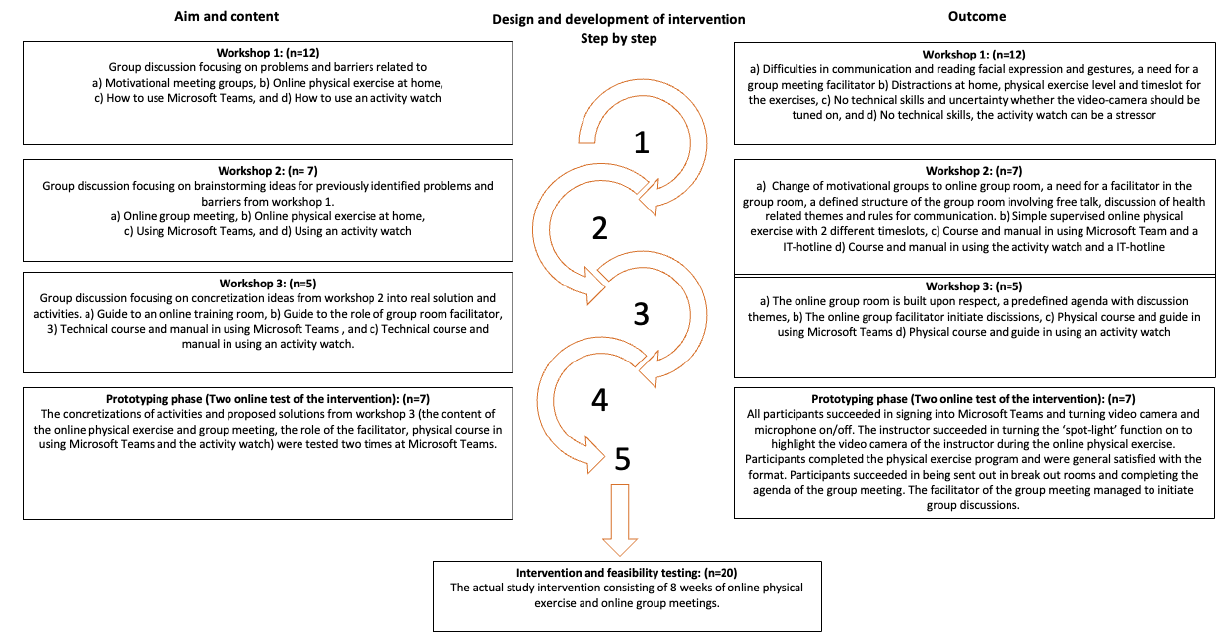
Figure 1. Design and development of the intervention using a co-creation approach. The development consisted of five steps: (1–3) three co-workshops, (4) a prototyping phase, and (5) the actual intervention.